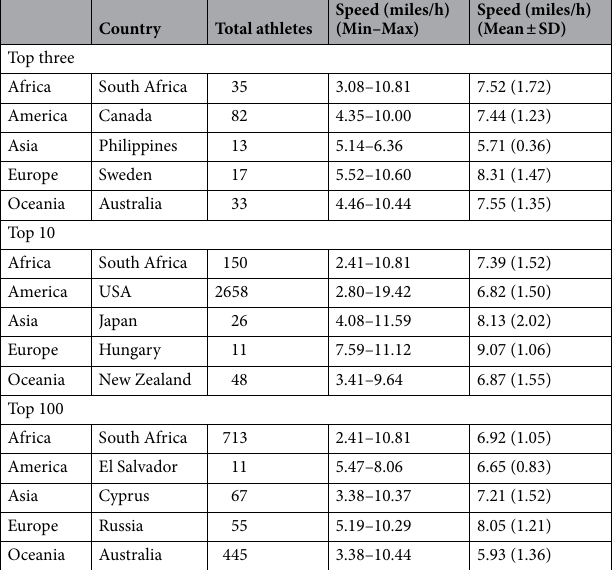
Table 2. Women descriptive results (min, mean ± SD, max) for the best country in each continent, based on performance level. Min–Minimum value; Max–Maximum value. SD standard deviation. We only considered the best country for each continent. Countries with total athletes below 10 were not considered.